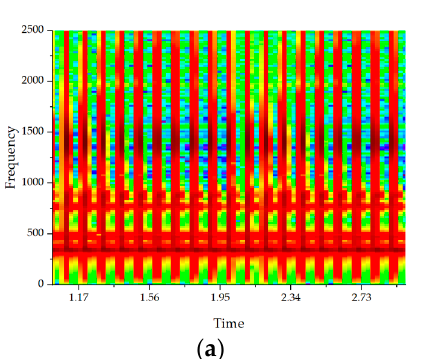
Figure 13. Acceleration response SFFT (Under constant-amplitude excitation); ( a ) No loosening; ( b ) One bolt loosened to 0.3 kN.